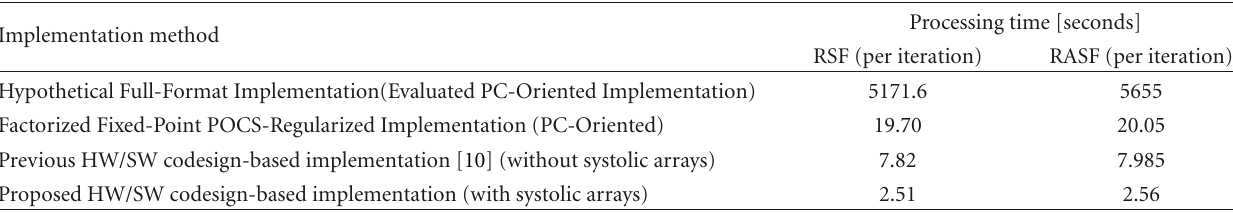
Table 4: Processing times required for implementing the conventional DEDR and the developed POCS-regularized (SW/HW codesign- based) unified DEDR-POCS techniques (RSF and